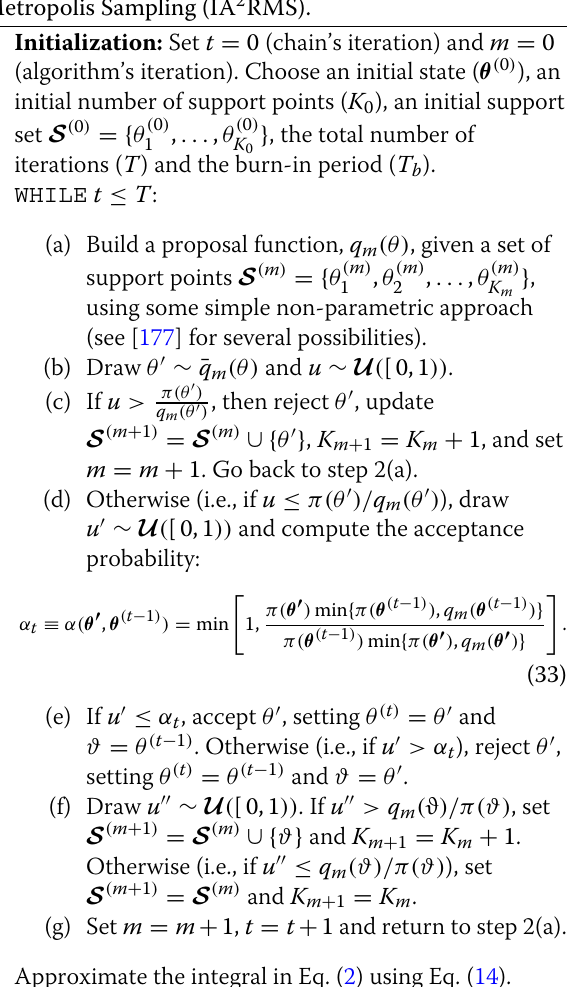
Algorithm 14 Independent Doubly Adaptive Rejection